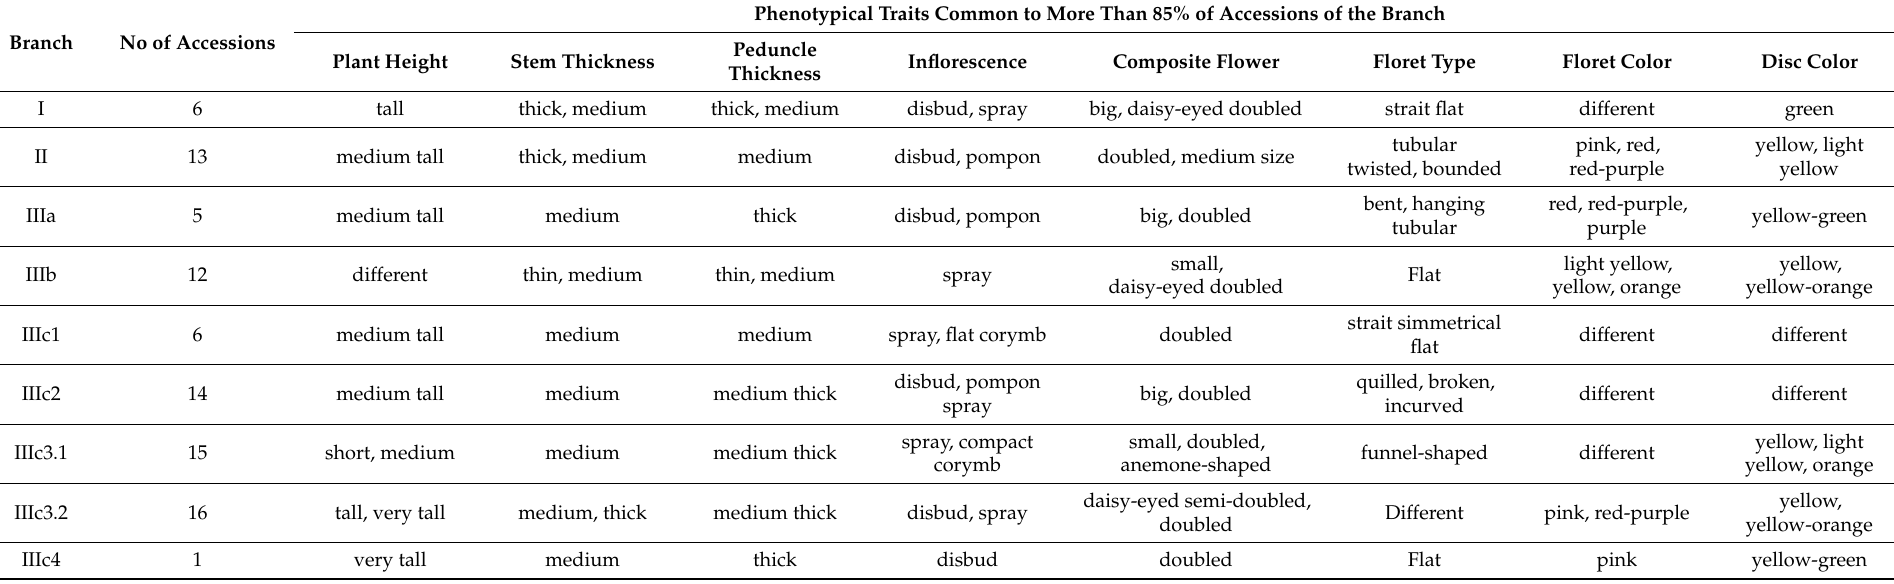
Table 2. Correspondence of the genetic positions with phenotypical